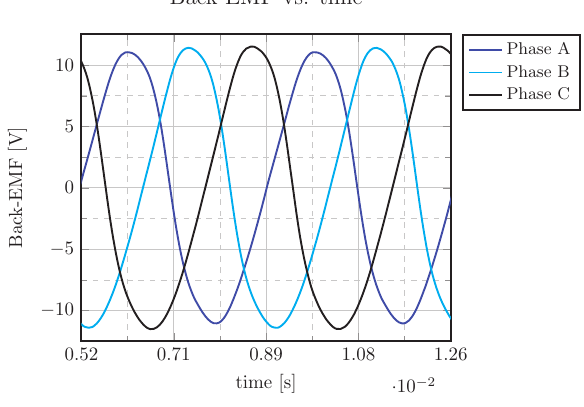
Figure 21. Back-EMF at 500 rpm.